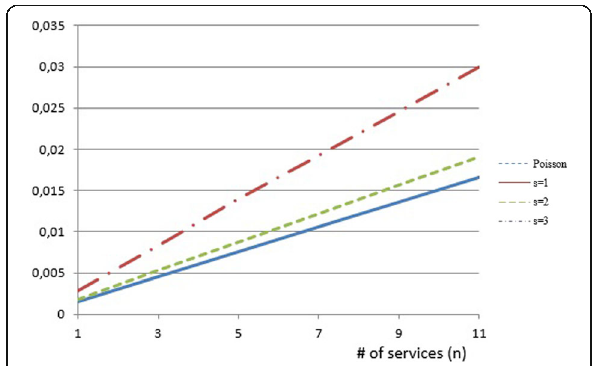
Fig. 5 Upper bounds of security v(A S ), privacy v(A P ) and service v(A G ) risks for various number of services n in cloud service